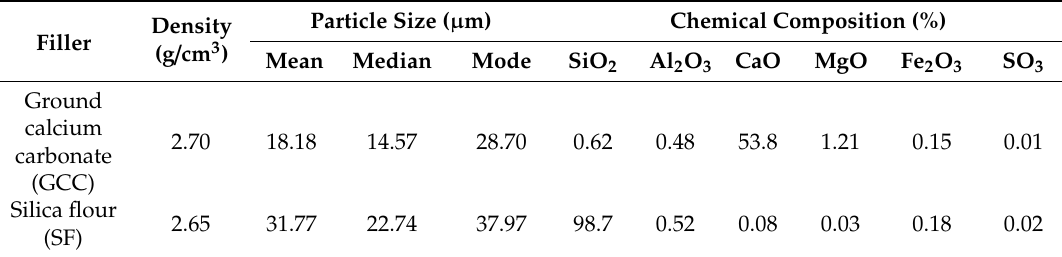
Table 4. Physical and chemical properties of crystalloid